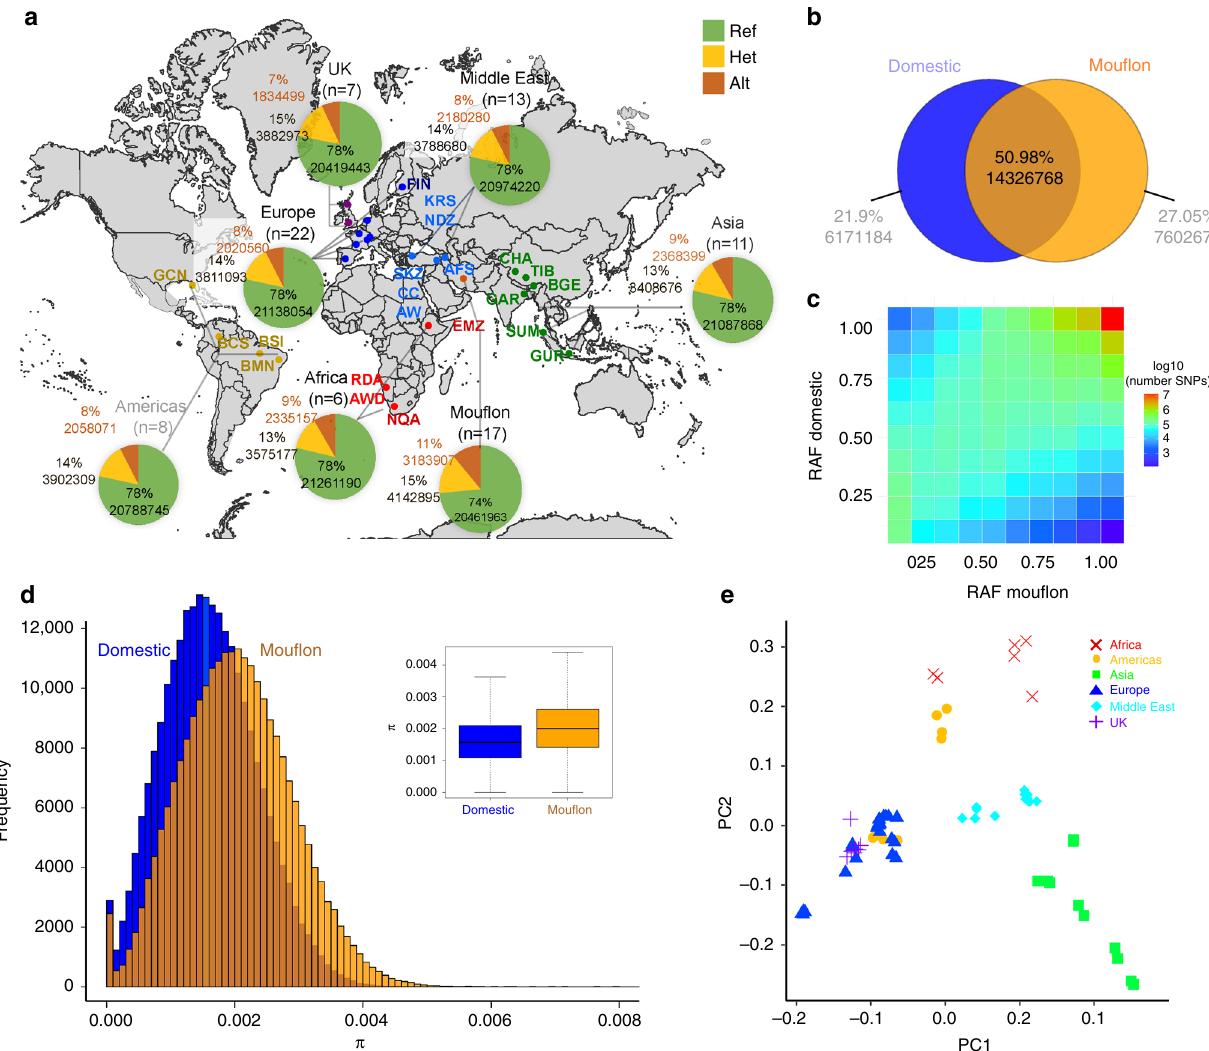
Fig. 1 Genome diversity and relatedness of wild and domestic sheep. a The geographic distribution of 43 breeds sampled for whole-genome sequencing. Population based proportion of allele type is given for each major geographic group of breeds, after calling reference variants present in the Texel derived genome assembly OARv3.1. b Proportion and number of private and shared SNP for the collection of wild and domestic sheep genomes. c Reference allele frequency (RAF) correlation between domestic and mou fl on populations. RAF domestic and mou fl on represent the frequency of the reference allele in domestic and mou fl on populations respectively. (Pearson correlation: 76.36% p -value < 2.2E − 16). d Distribution of nucleotide diversity ( π ) within species, estimated within 20 kb bins. The boxplot compares the bin mean and variance. The distribution means, evaluated using the Wilcoxon rank-sum test, are signi fi cantly difference ( p -value < 2.2E − 16). e Principal component (PC) analysis clustering individual domestic sheep coloured to re fl ect the